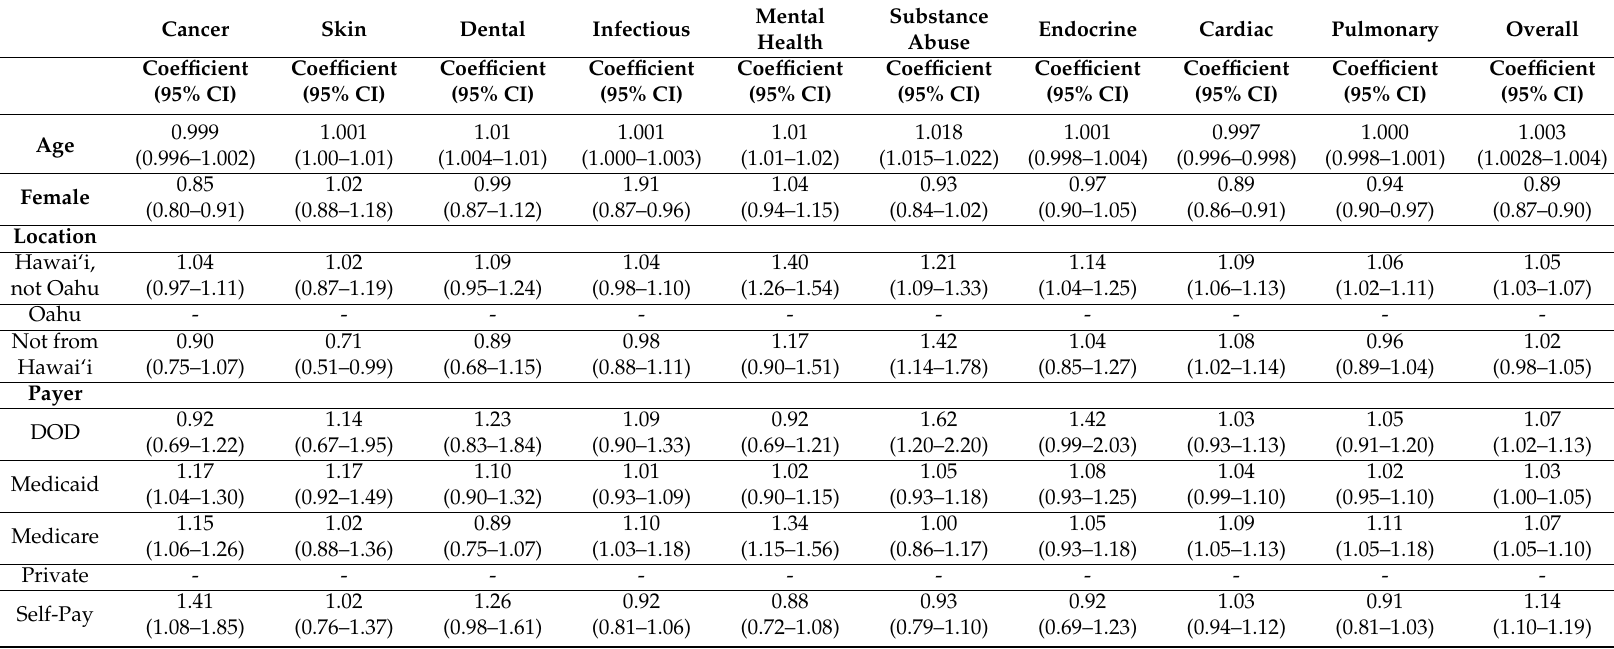
Table A2. Significant Variables in Multivariable Models without Severity of Illness